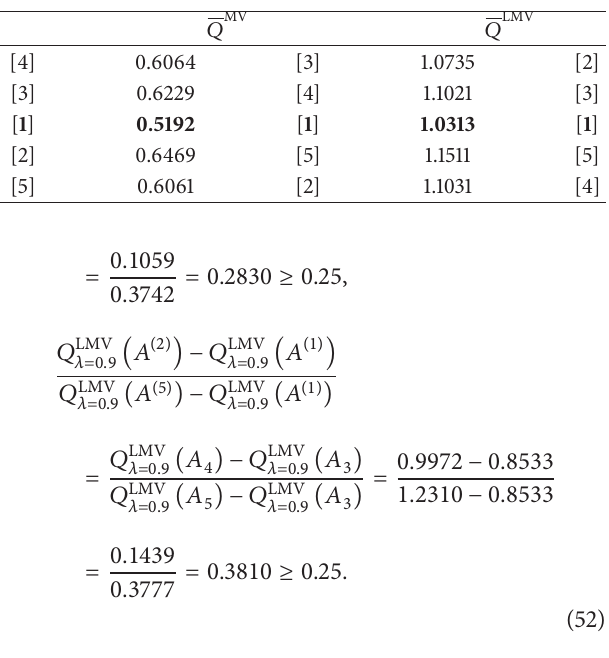
Table 15: Ranking of alternatives with respect to average values of 𝑄